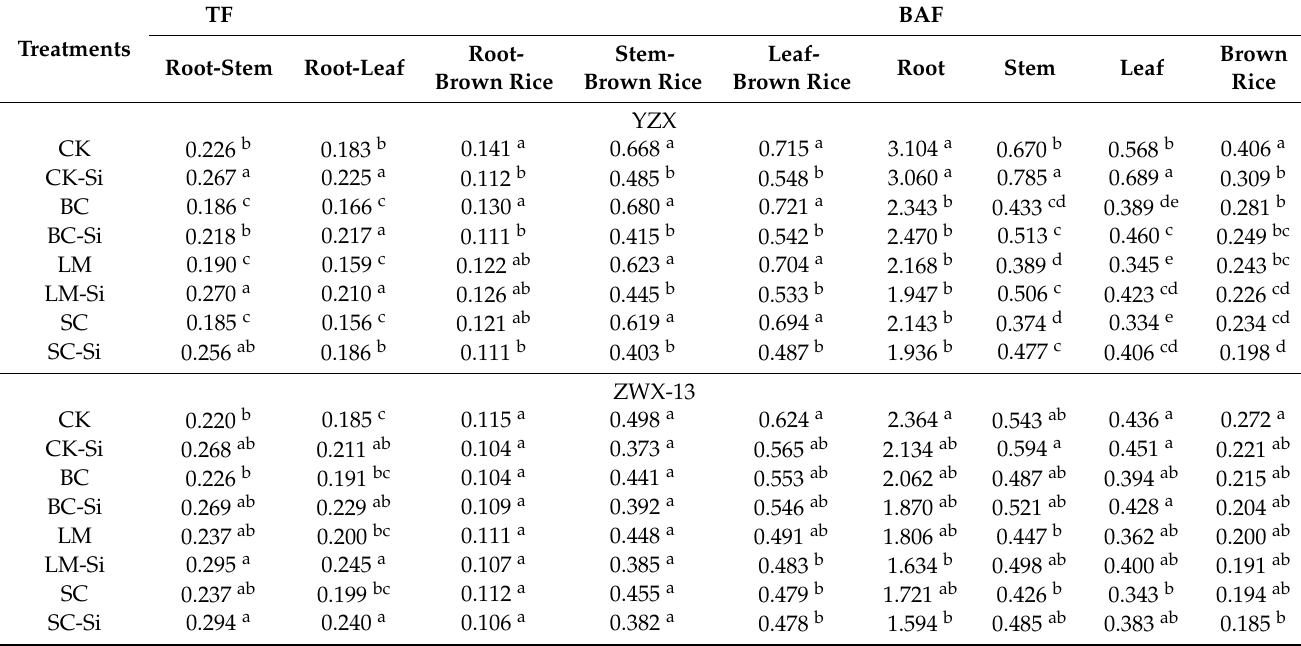
Table 4. Translocation factors (TFs) and bioaccumulation factors (BAFs) for Cd for different parts of the late rice